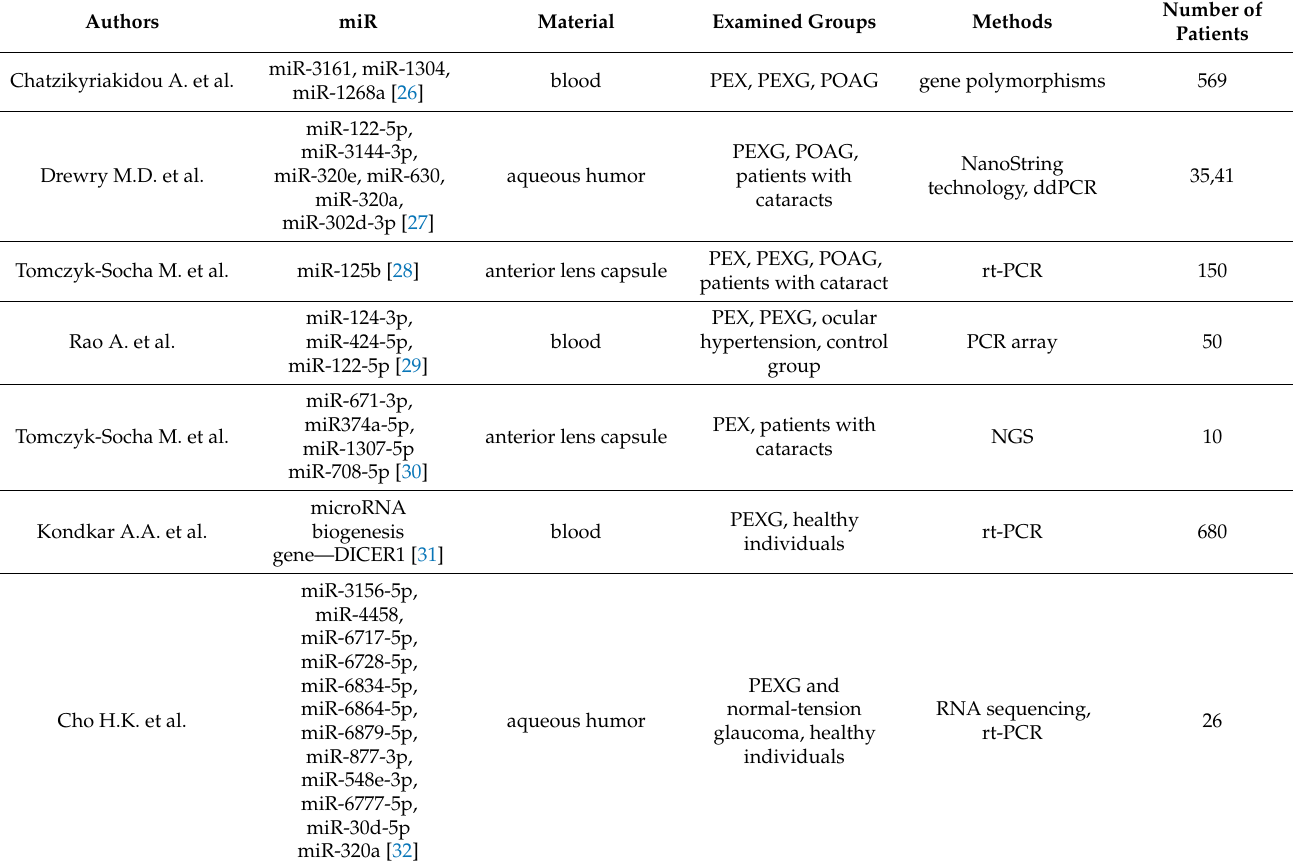
Table 1. Examined miR in pseudoexfoliation